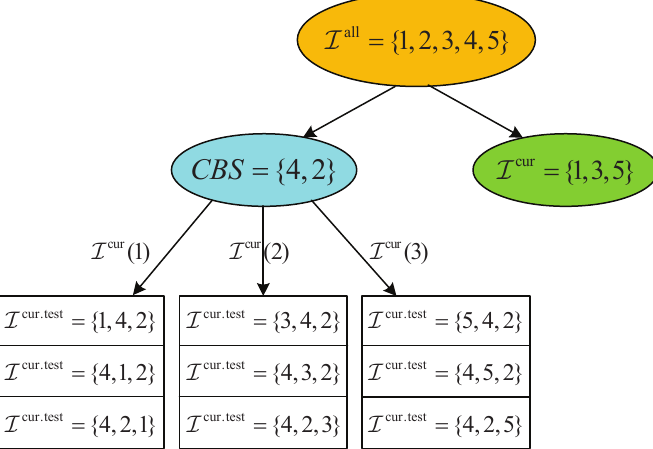
Figure 5. An illustrative example when executing Algorithm